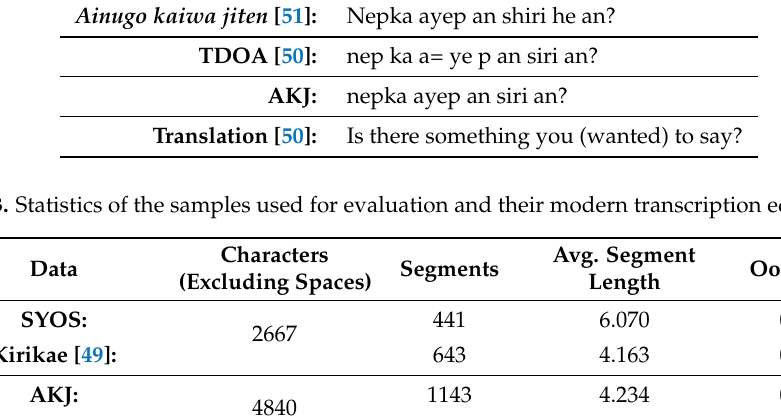
Table 2. A fragment from the Talking Dictionary of Ainu (TDOA)/Ainugo kaiwa jiten (AKJ) dataset.